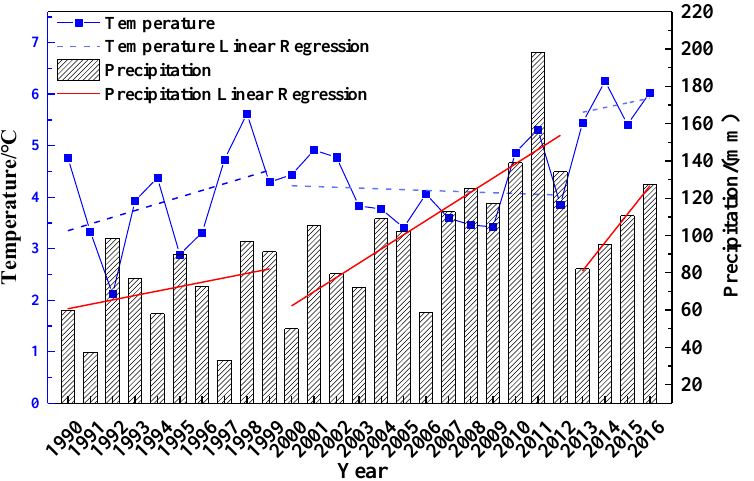
Figure 6. Inter-annual average air temperature and precipitation from 1990 to 2016 at the Taxkogan meteorological station.